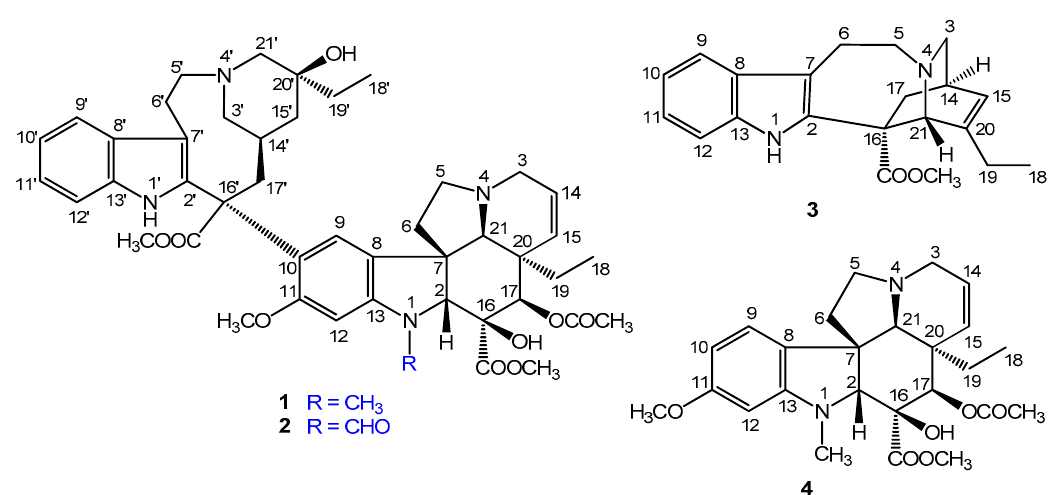
Figure 1. The alkaloids vinblastine ( 1 ), vincristine ( 2 ), catharanthine ( 3 ) and vindoline ( 4 ).